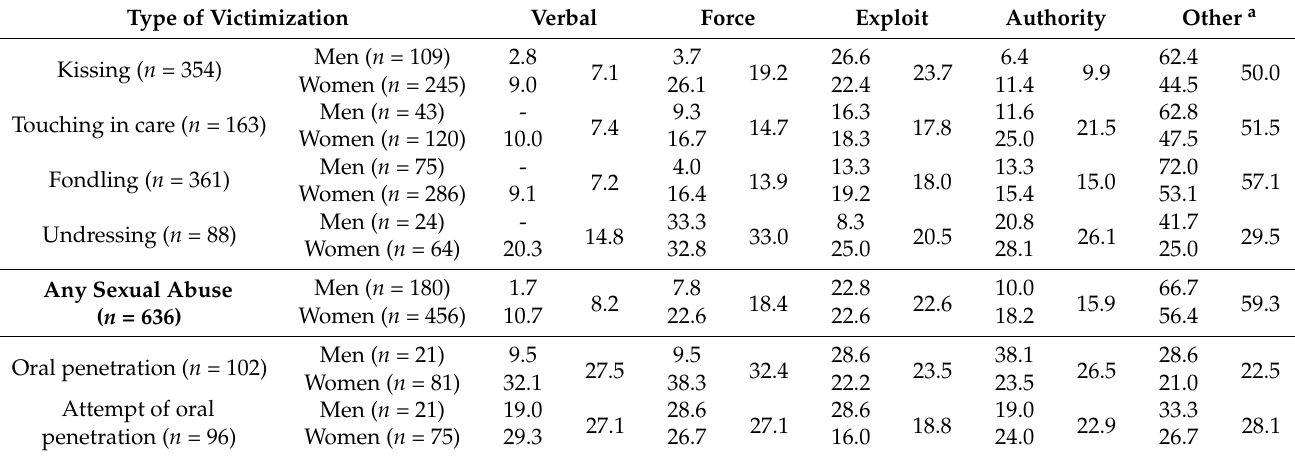
Table 6. Type of coercion used for sexual abuse, rape, and attempted rape, in %, overall and by sex. Type of